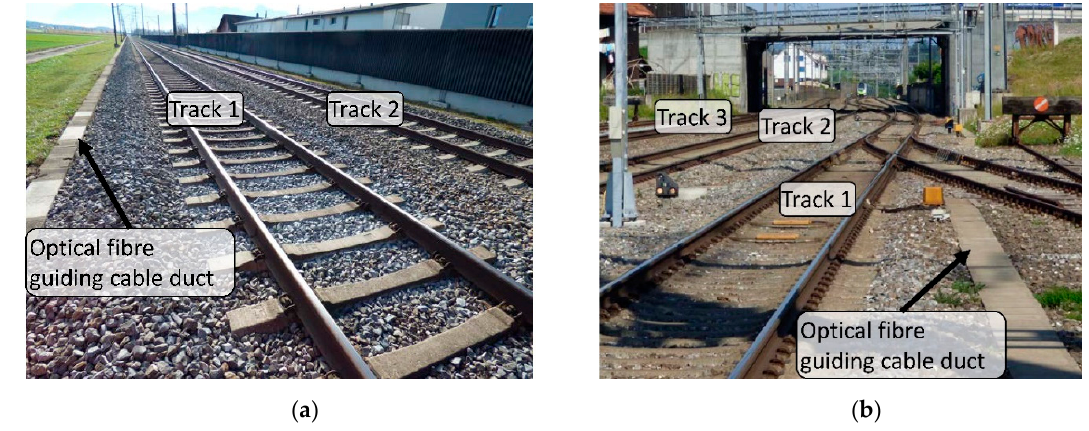
Figure 3. ( a ) Cable duct parallel to track 1 guiding and protecting the optical fibre. There is usually only one cable duct, located on the left-hand side of track 1, even though it is mostly a double-tracked line; ( b ) in the case of multitracked sections, one cable duct is provided whereby the fibre layout may change significantly, especially in the vicinity of bridges and turnouts, resulting in considerable fibre length excess.